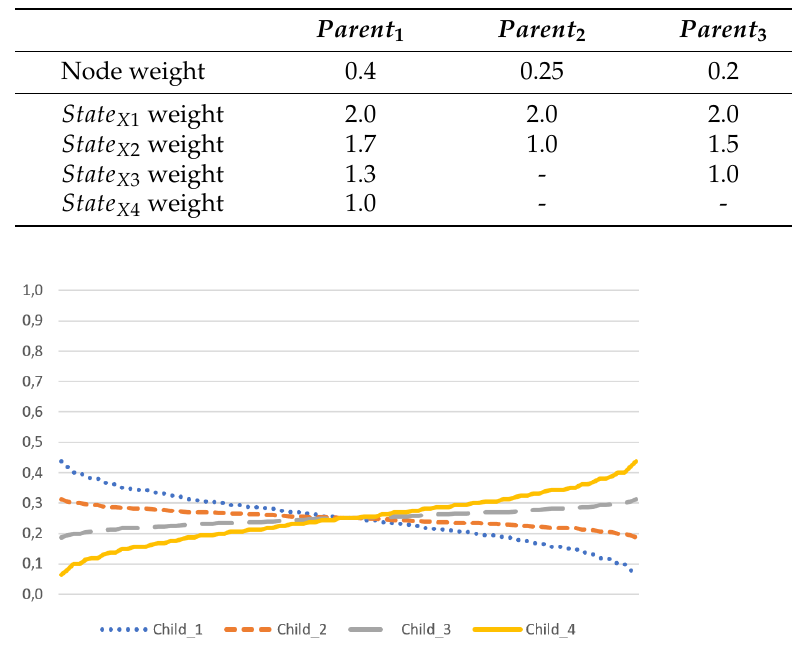
Figure 5. Hassall’s algorithm: the probability per child state, given the ordening of the parents states on the x-axes.